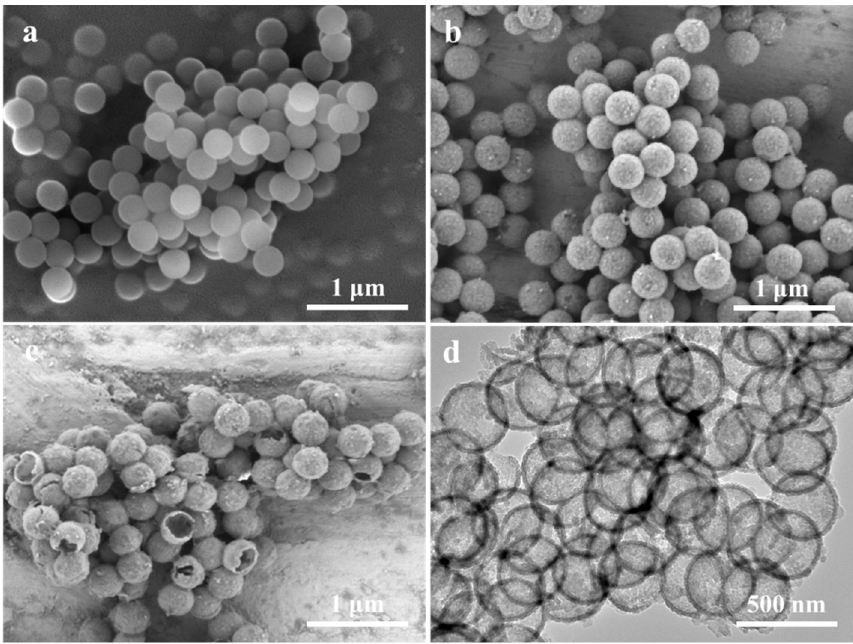
Figure 1. SEM images of PS ( a ) and PS@ZIF ‐ 8 ( b ); SEM ( c ) and TEM( d ) images of hollow ZIF ‐ 8 par ‐ ticles.